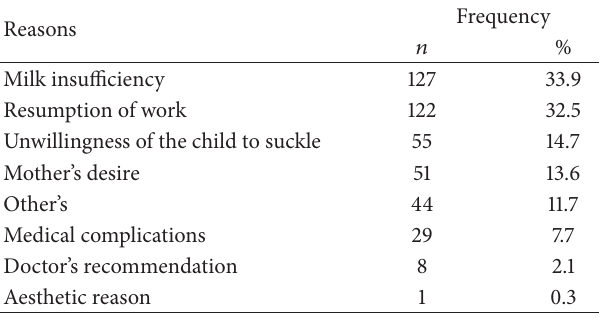
Table 3: Reasons for opting infant